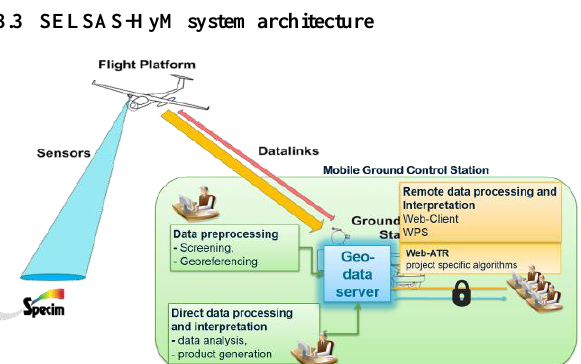
Figure 3: SELSAS-HyM System